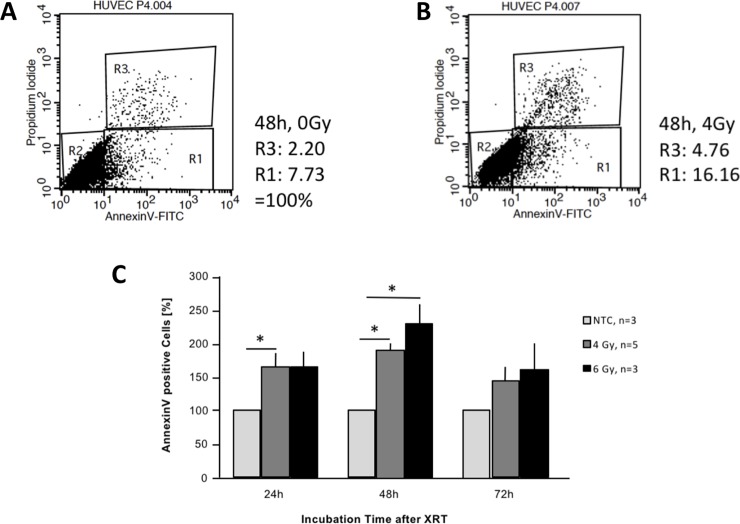
Upregulation of phosphatidylserine (PS) on the cell surface of human endothelial cells (HUVEC) by radiation in vitro.(A) PS (Annexin V positive, R1) versus propidium iodide (PI; R3) staining without irradiation (control) after 48 hours of incubation. 2.2% of the cells were PI-positive (necrotic) and 7.73% of the cells stained positive for PS. (B) PS versus PI staining after irradiation with 4 Gy and 48 hours of incubation. (C) Quantitative results of all independent experiments (3- to 5-fold for control and 6 Gy, 5-fold for 4 Gy). Asterisks represent comparisons with two-sided p-values <0.05 (24 hours: control vs. 4 Gy, p = 0.022; control vs. 6 Gy, p = 0.092 (n was only 3, variation was larger). 48 hours: control vs. 4 Gy, p = 0.0002; control vs. 6 Gy, p = 0.043). Values at 72 hours were not significant since spontaneous apoptosis of the cells without radiation varied and increased. The no-treatment control (NTC) values have been normalized to 100% and the other values have been given as mean percentages of control with standard error (SE) bars.